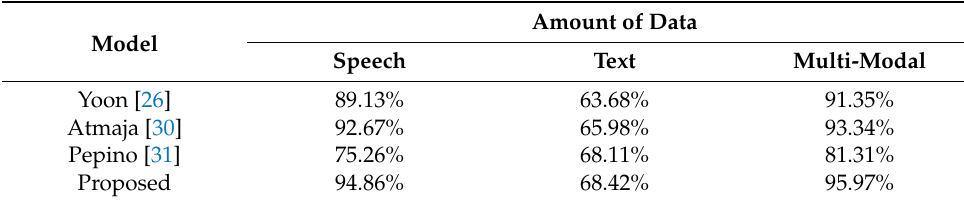
Table 2. Accuracy comparison with other